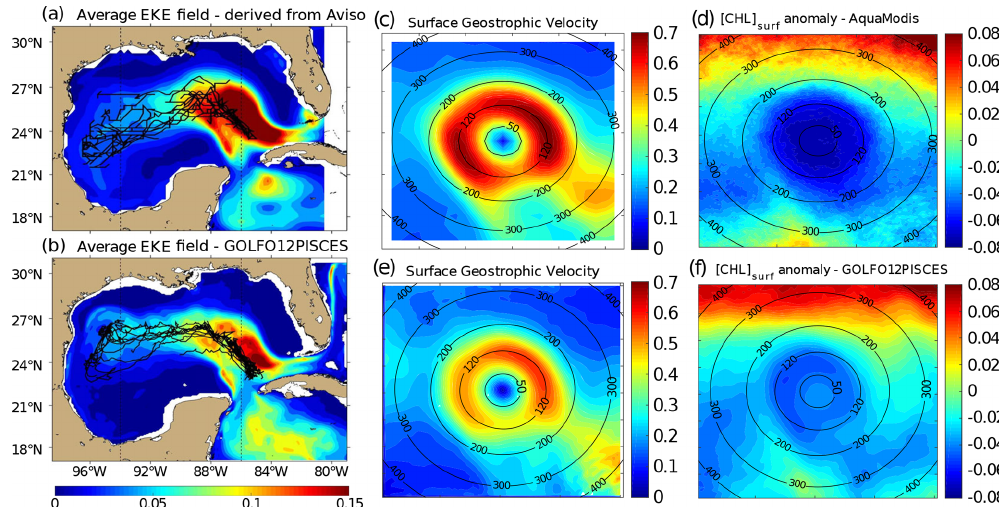
Figure 2. Average eddy kinetic energy (EKE) field derived from (a) Aviso geostrophic surface velocities and from (b) GOLFO12-PISCES currents at 10m depth. The trajectories of the tracked LCEs are superimposed to the EKE field (black lines). Dashed vertical black lines indicate the central GoM area over which composites are built. Annual LCE composite images of surface geostrophic velocities for (c) Aviso images and (e) GOLFO12-PISCES. Annual LCE composite images of surface chlorophyll concentration anomaly for (d) MODIS images, and (f) GOLFO12-PISCES. Black circles indicate the radius in kilometers.